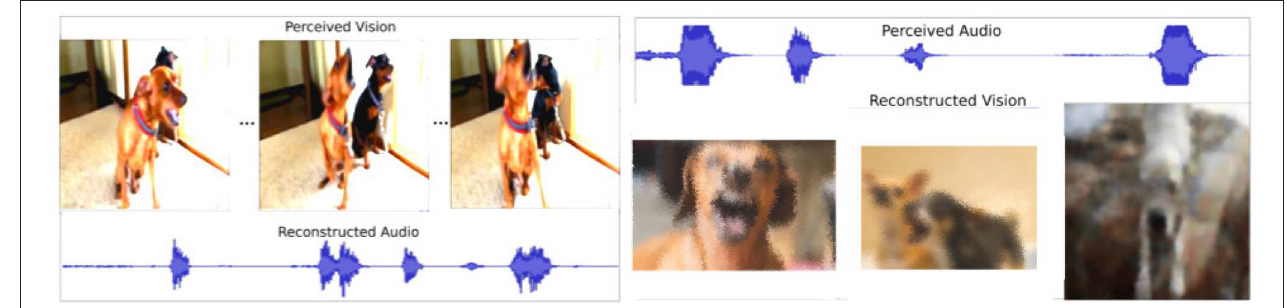
FIGURE 3 | Example of the reconstruction output. The left image displays the audio reconstruction when the visual stimulus is perceived. The right image displays the vision reconstruction when the audio stimulus is